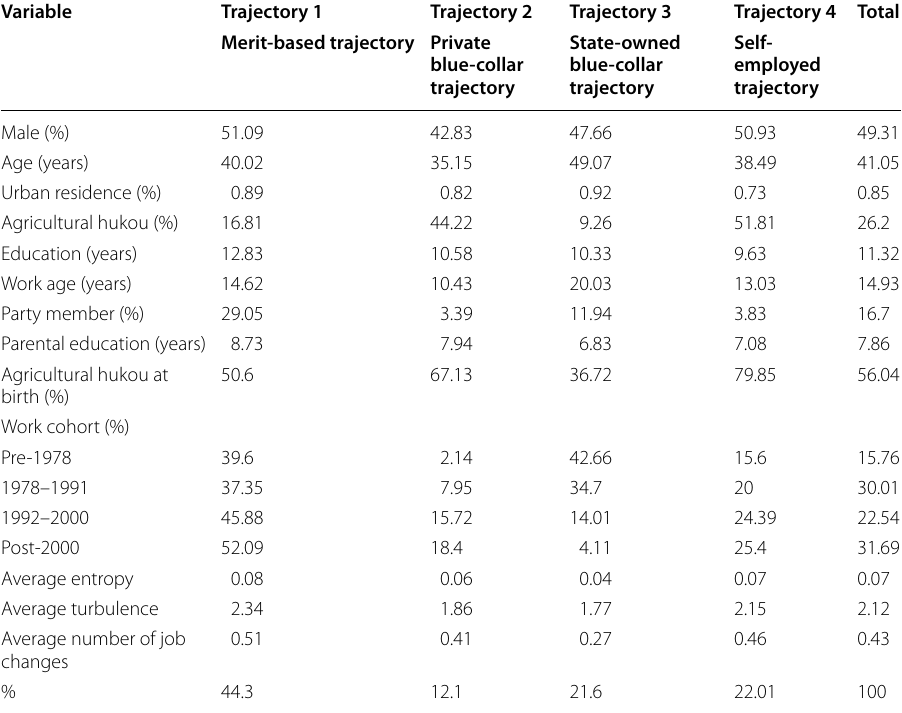
Table 1 Main group characteristics of the four typical work trajectories ( N